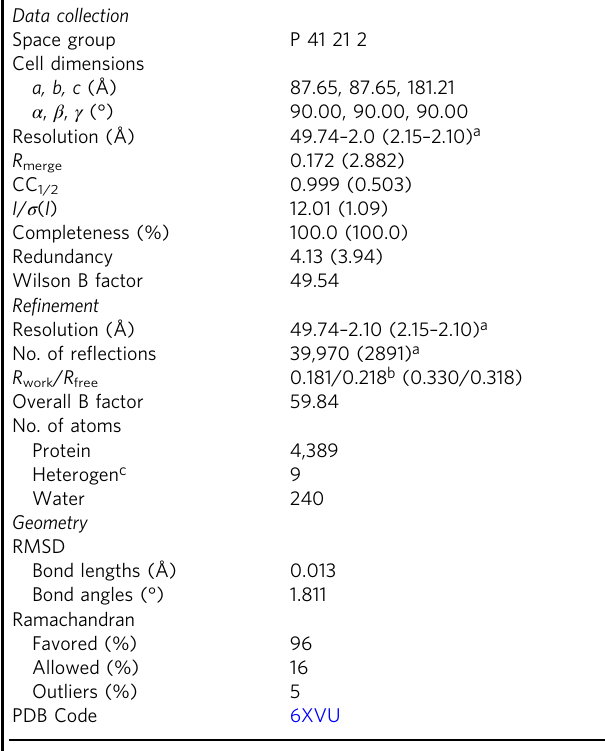
Table 1 Crystal data collection and processing statistics. Data collection Space